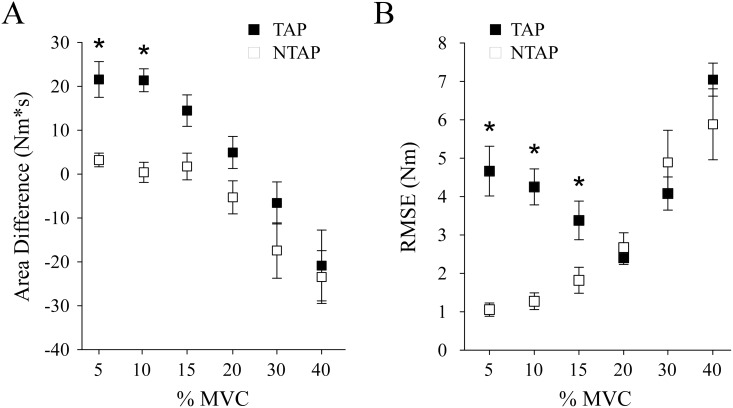
Torque output measures.Area (A) and RMSE (B) for each target torque level. Asterisks indicate significant differences between TAP and NTAP values (p < 0.05). Values are means ± SE.